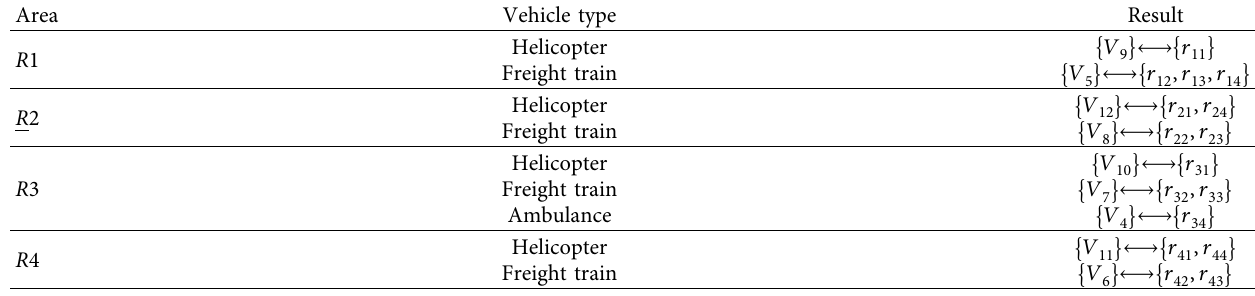
Table 4: Information on vehicles.